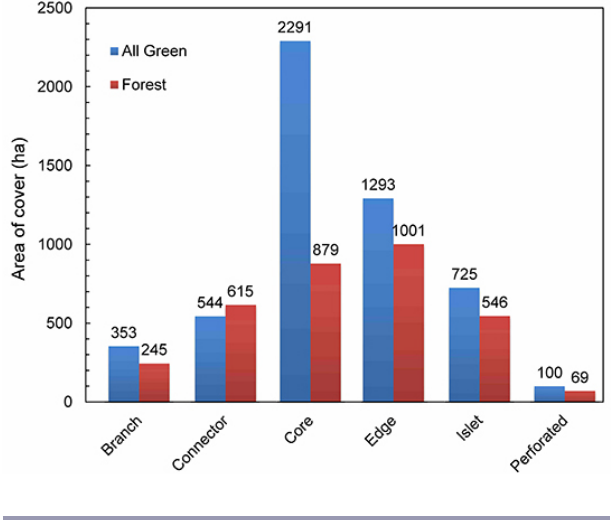
Fig. 2. Amount of area covered by different spatial patterns of urban green areas and forests in San Juan, Puerto Rico. See Table 1 for definitions of spatial